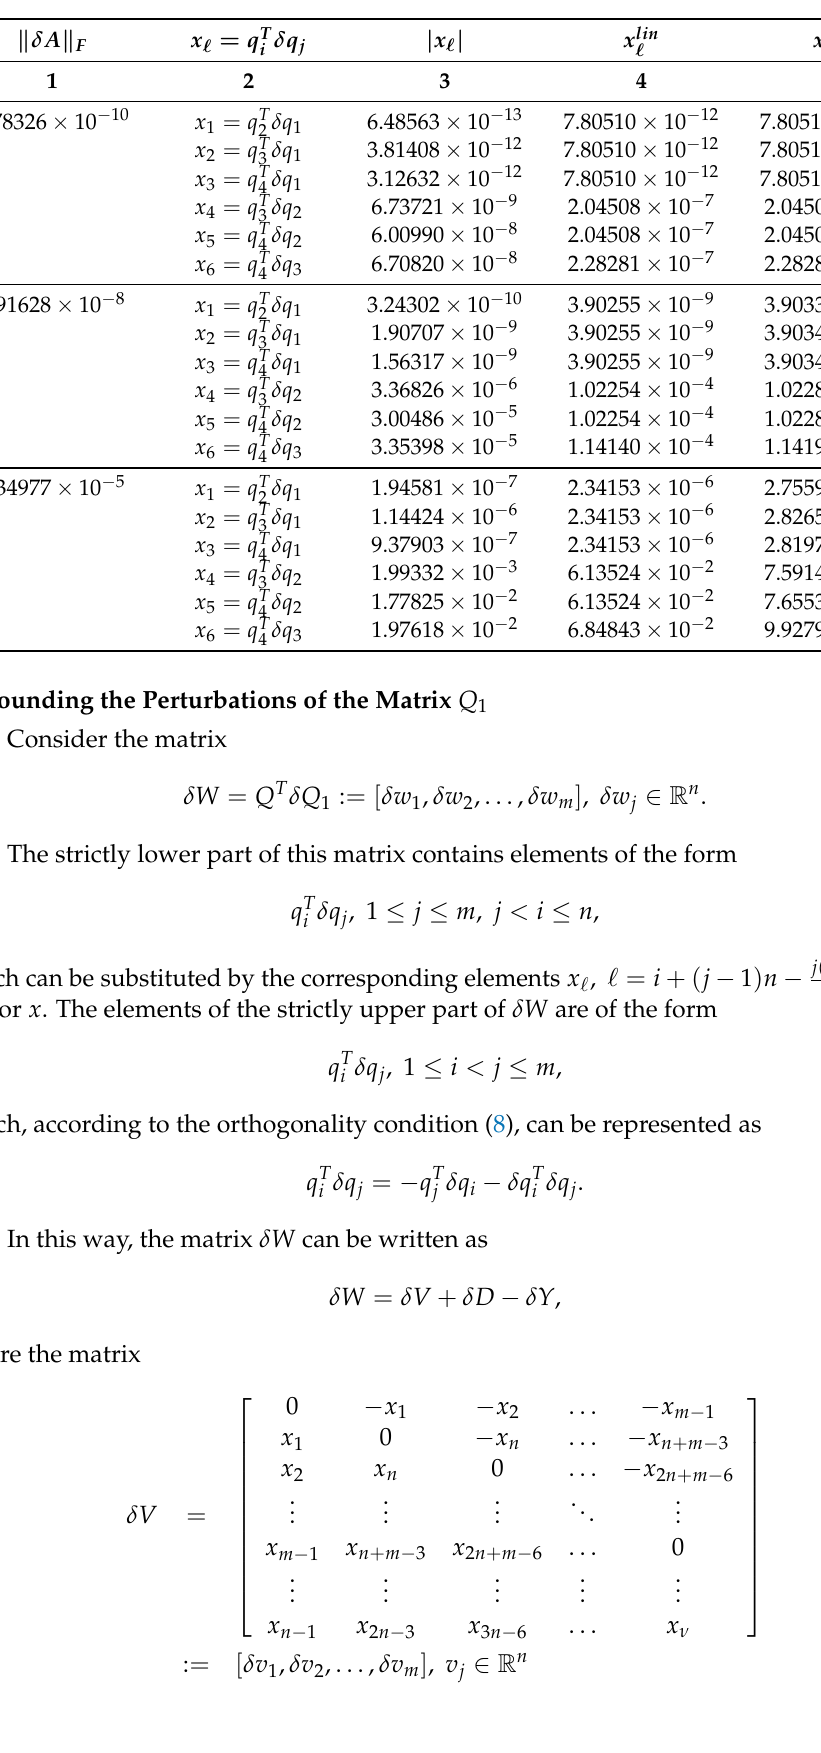
Table 1. Exact basic perturbation parameters and their linear and nonlinear